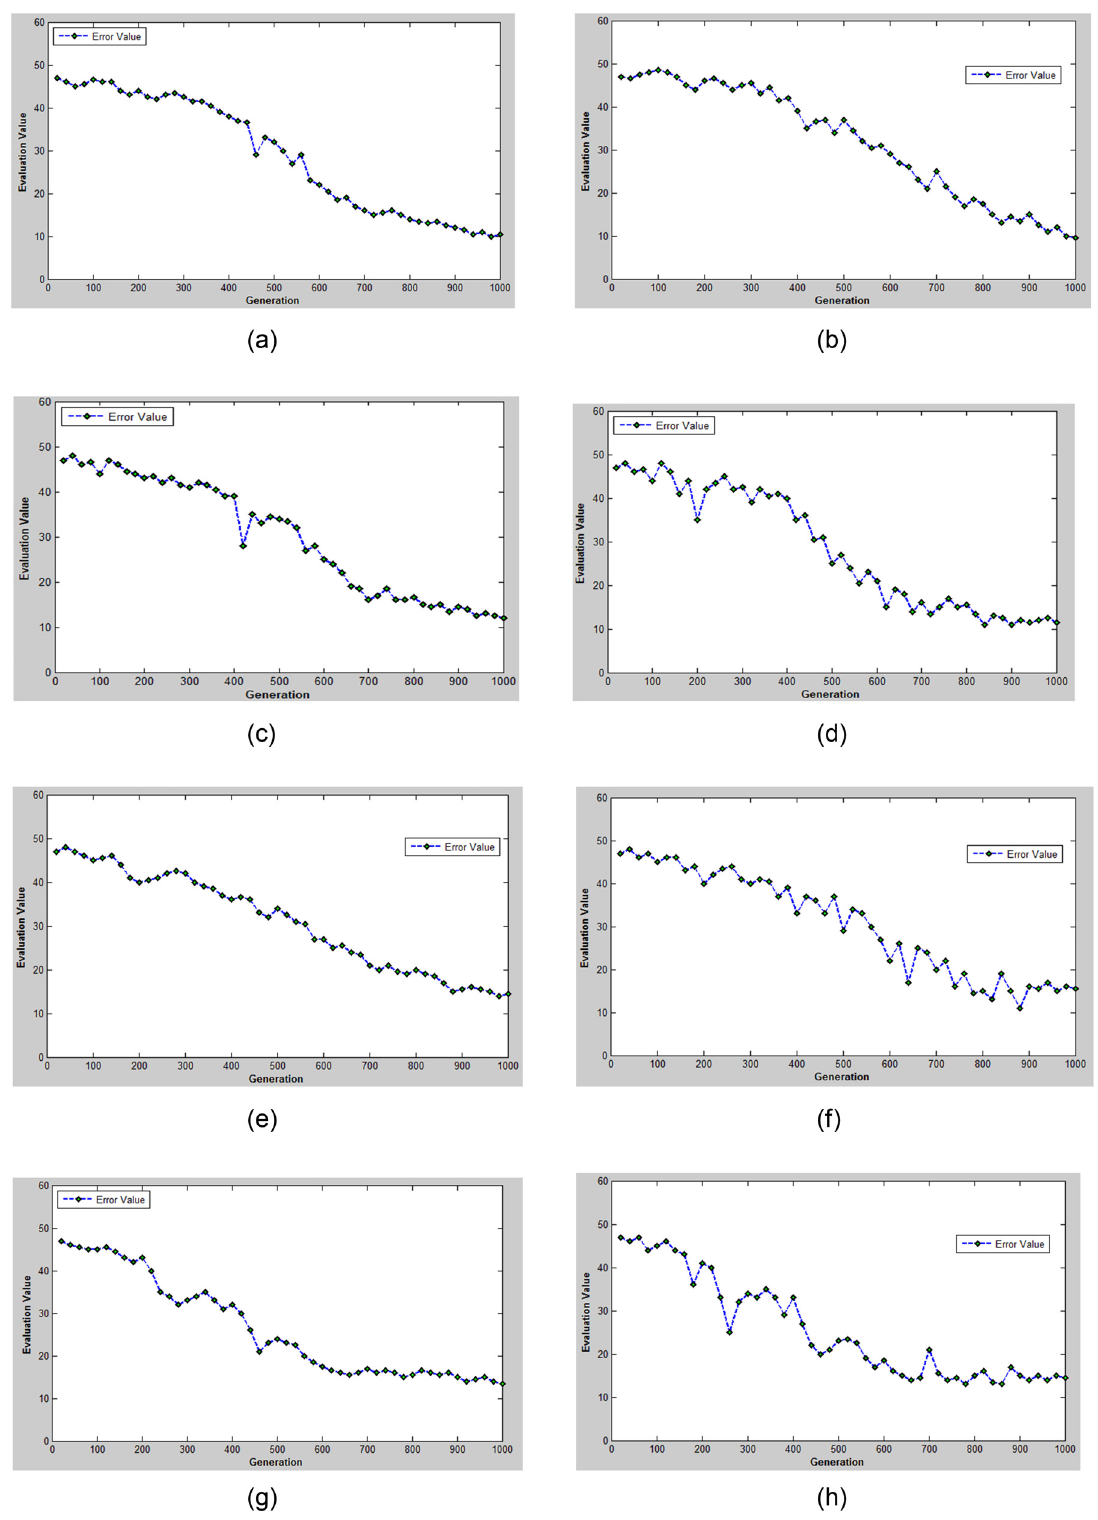
Figure 3: The estimation performances of the SOESIPSO with di ff erent parameters: ( a ) performances by C1 = C2 = 1.5, rand = 0.3; ( b ) performances by C1 = C2 = 1.5, rand = 0.5; ( c ) performances by C1 = C2 = 2, rand = 0.3; ( d ) performances by C1 = C2 = 2, rand = 0.5; ( e ) performances by C1 = 1.5, C2 = 2, rand = 0.3; ( f ) performances by C1 = 1.5, C2 = 2, rand = 0.5; ( g ) performances by C1 = 2, C2 = 1.5, rand = 0.3; ( h ) performances by C1 = 2, C2 = 1.5, rand =